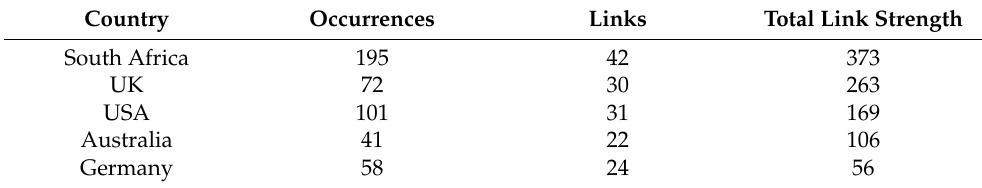
Table 2. Most co-operative publishing countries according to total link strength. Country Occurrences Links Total Link Strength South